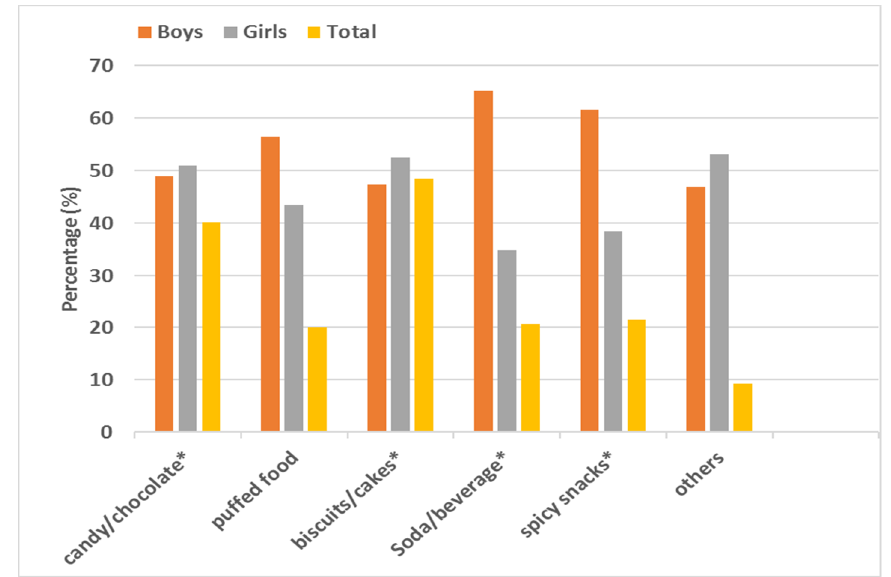
Figure 3. Types and percentages of snacks consumed more than three times a week by